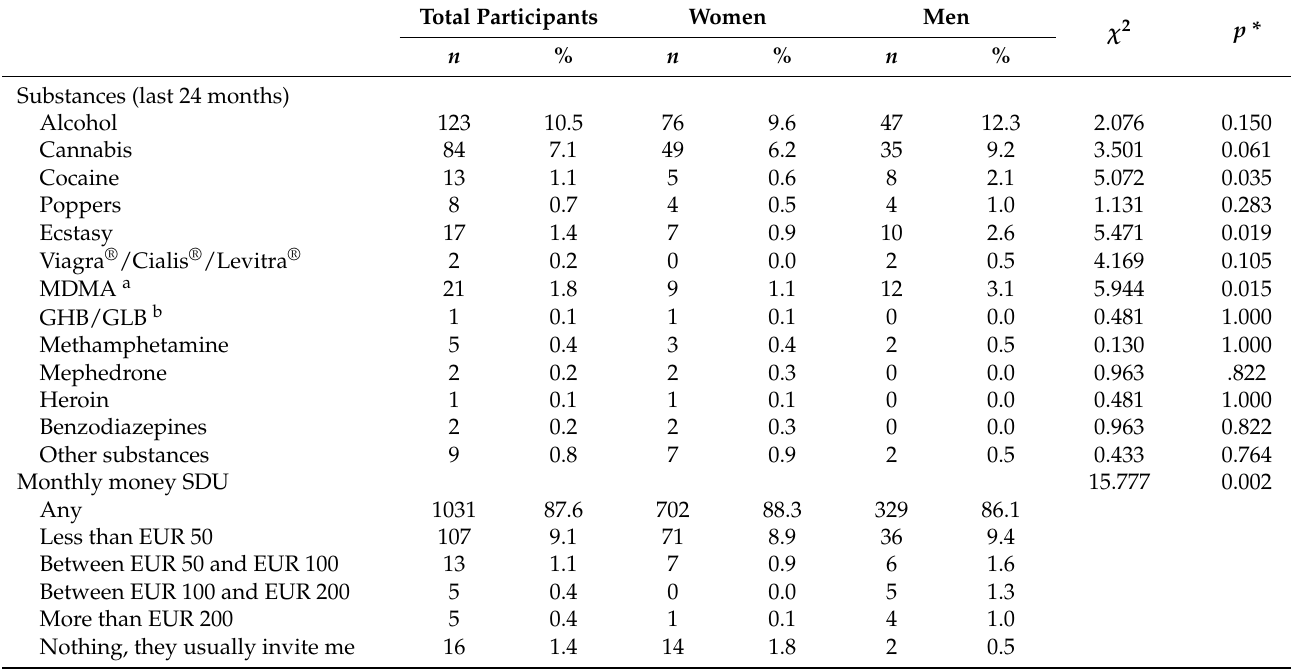
Table 2. SDU Prevalence and Substance Use Among Heterosexual Women and